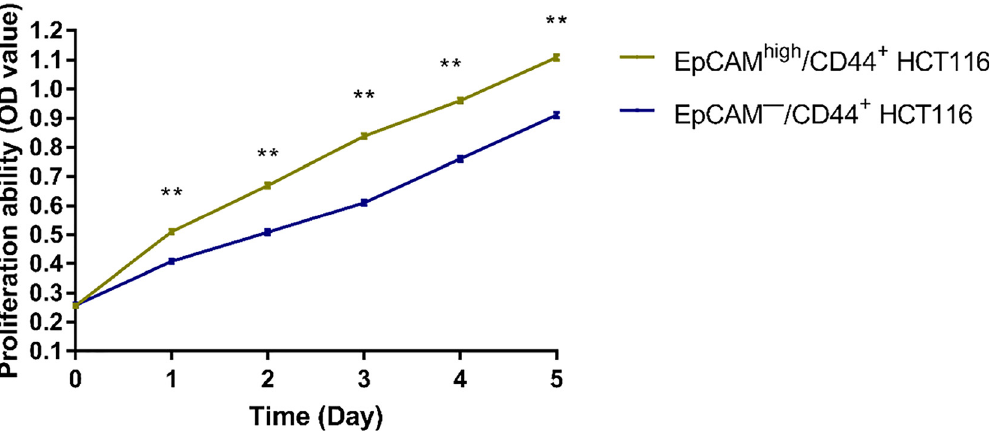
Figure 3: Comparation EpCAM − /CD44 + HCT116 cells with EpCAM high /CD44 + HCT116 cells for the proliferation ability. **p<0.01 vs. control